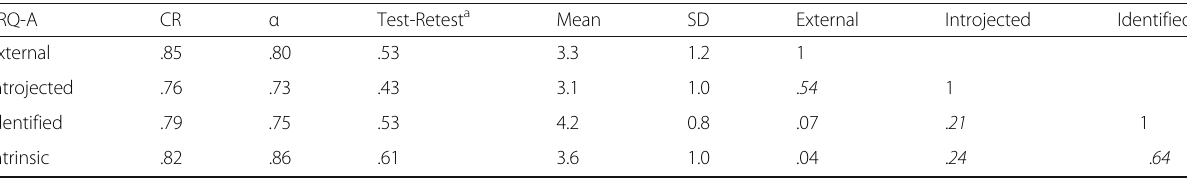
Table 4 General psychometric characteristics of the Portuguese SRQ-A (16 items) SRQ-A CR